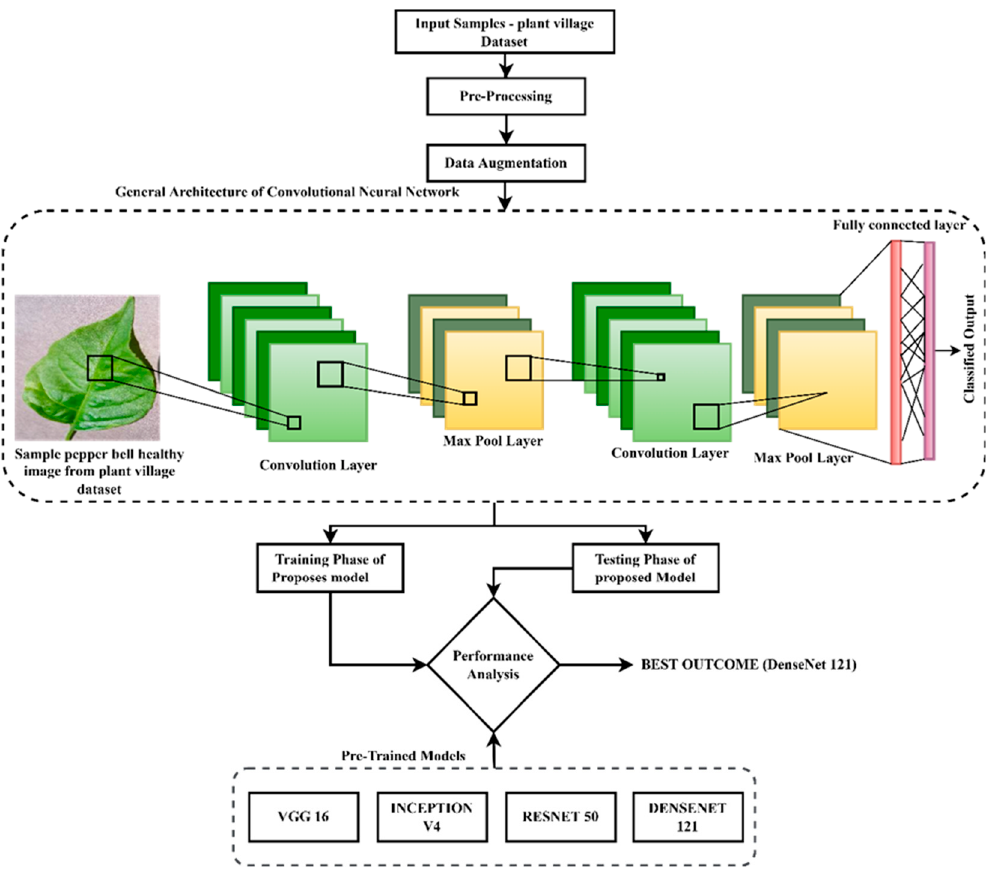
Figure 3. Overall workflow diagram.